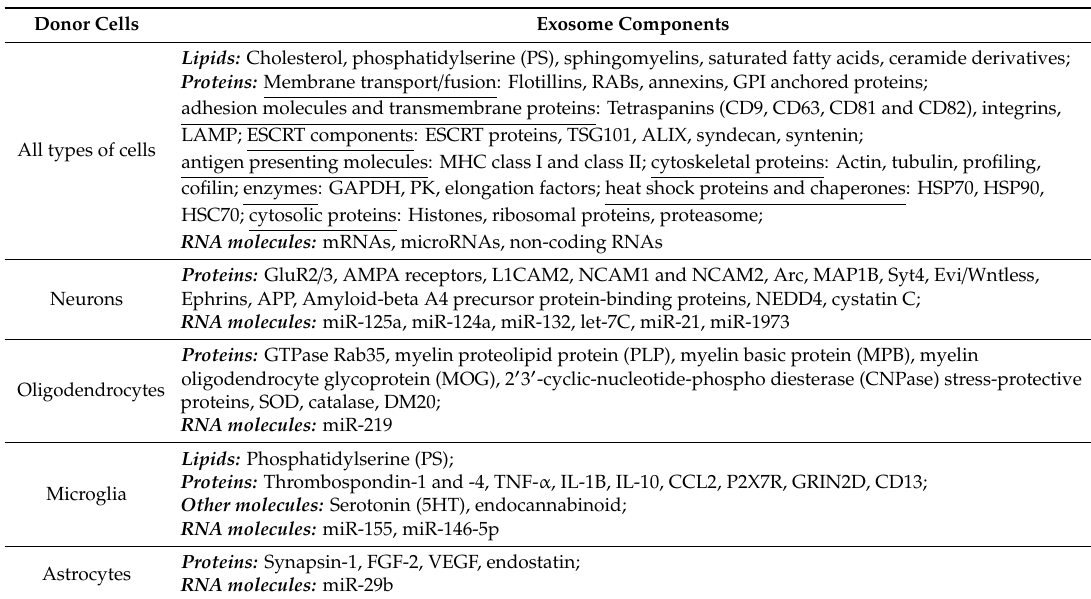
Table 1. Biochemical composition of